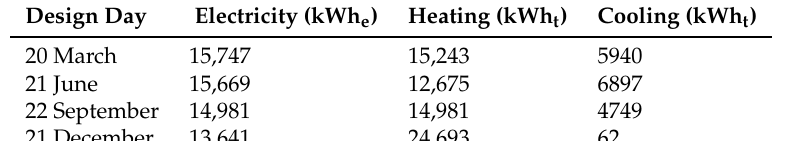
Table 1. Average loads on four example days.